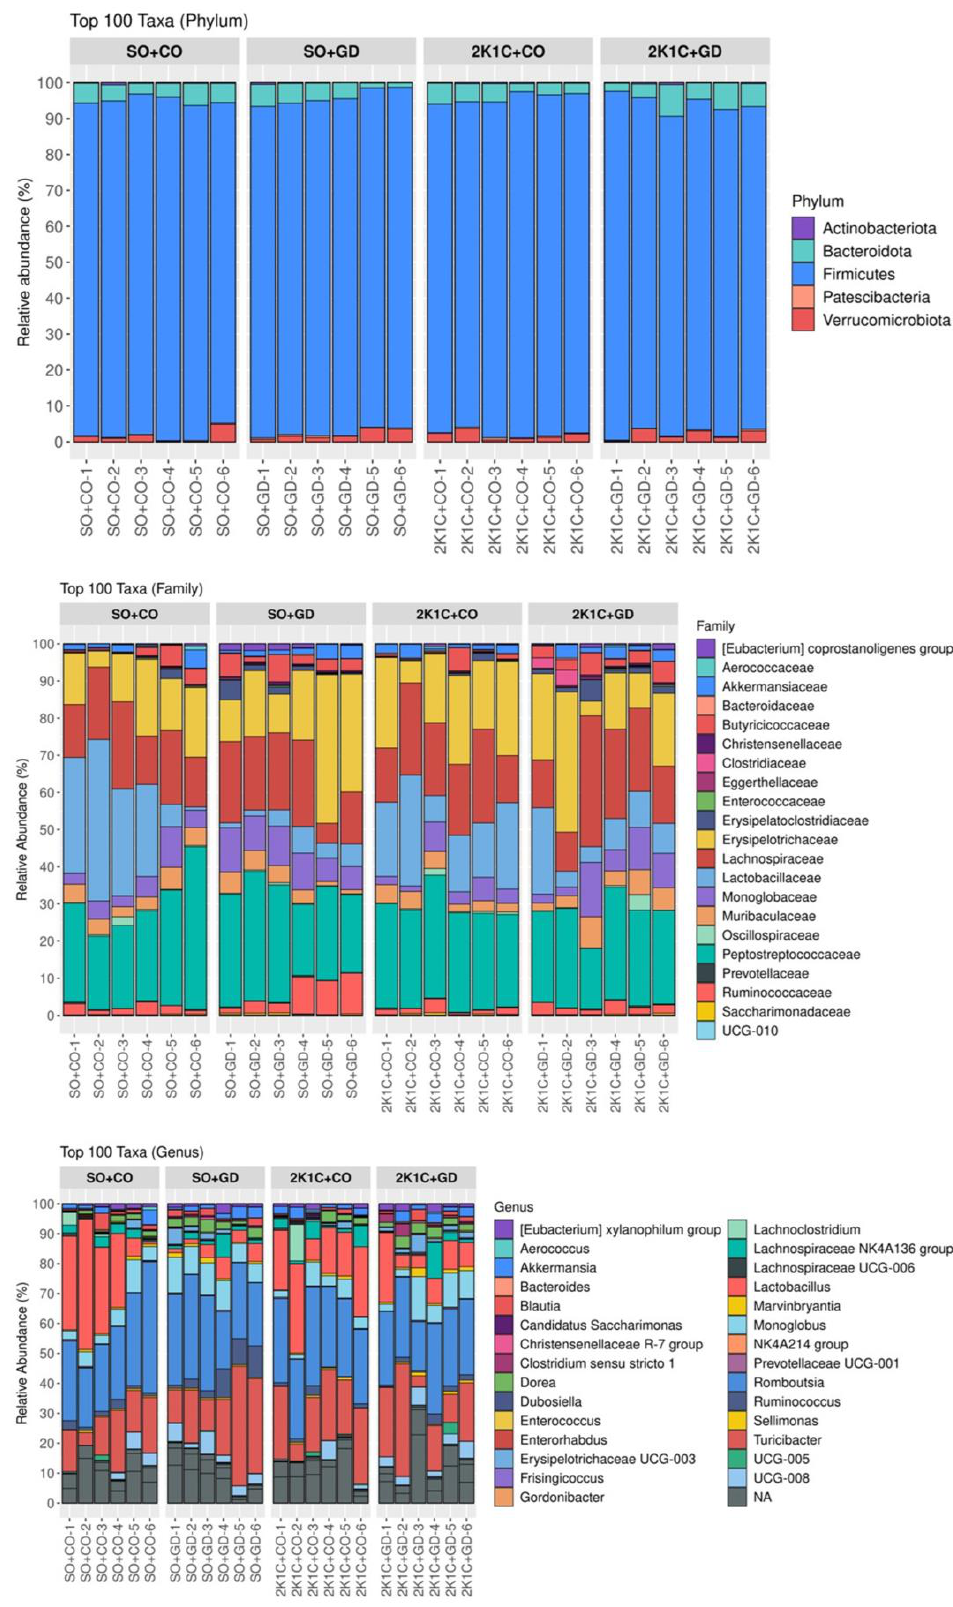
Figure 6. Taxonomic profiles of the bacterial communities illustrated at the phylum, family and genus levels. SO, sham operation; CO, corn oil; 2K1C, 2-kidneys-1 clip; GD, Garcinia dulcis flower extract.